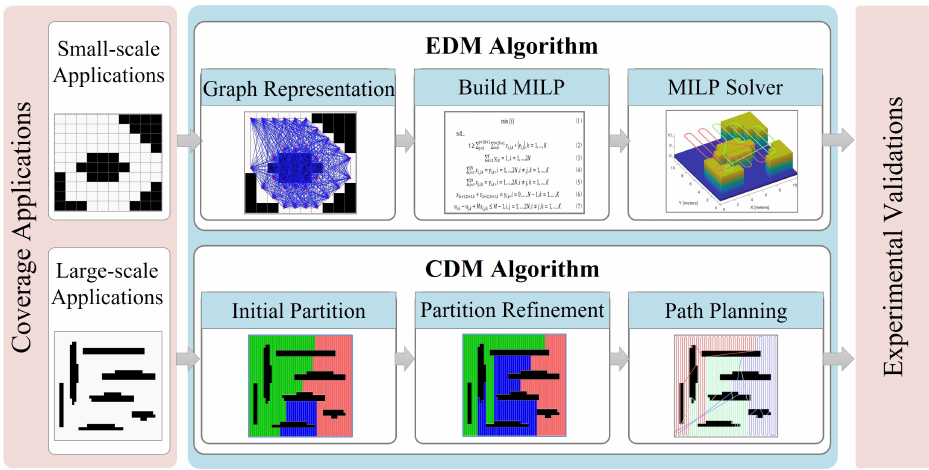
Figure 2. An overview of the Dubins coverage